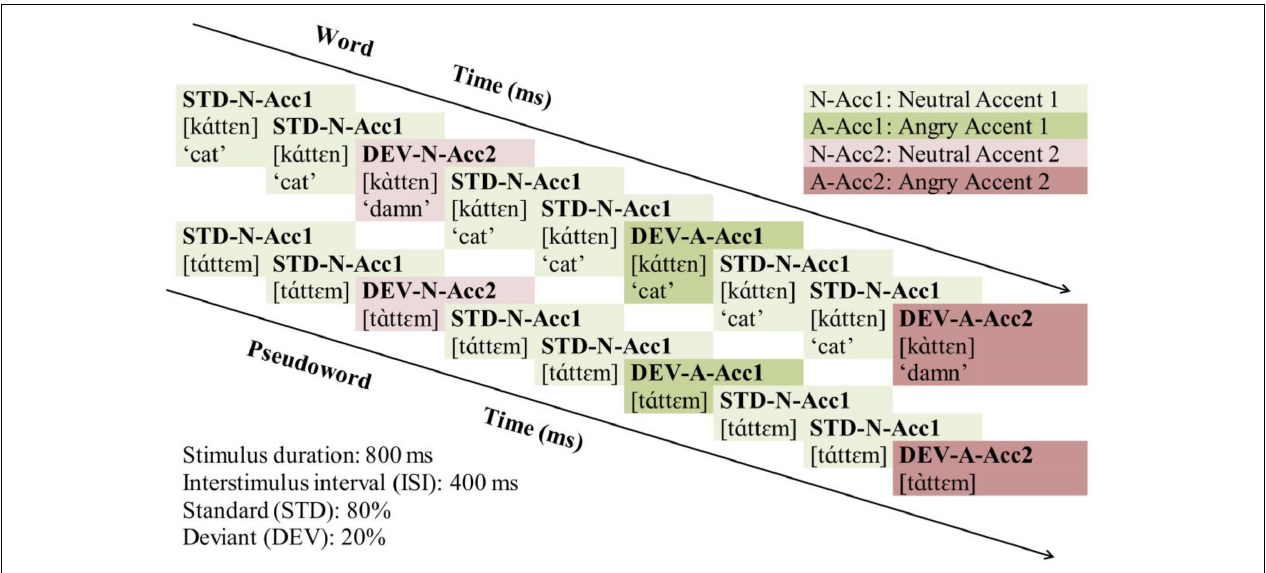
FIGURE 1 | Illustration of the experimental paradigm across Word and Pseudoword blocks. STD, Standard; DEV, Deviant; N, Neutral; Acc, Accent. Neutral stimuli with Accent 1: Light green; Neutral stimuli with Accent 2: Light pink; Angry stimuli with Accent 1: Dark green; Angry stimuli with Accent 2: Dark pink.